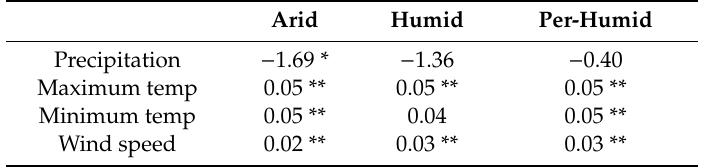
Table 2. The Sen’s slope in trend analysis for annual precipitation (mm / year) and maximum and minimum temperatures ( ◦ C / year) in each climate zone from 1988 to 2012. Arid